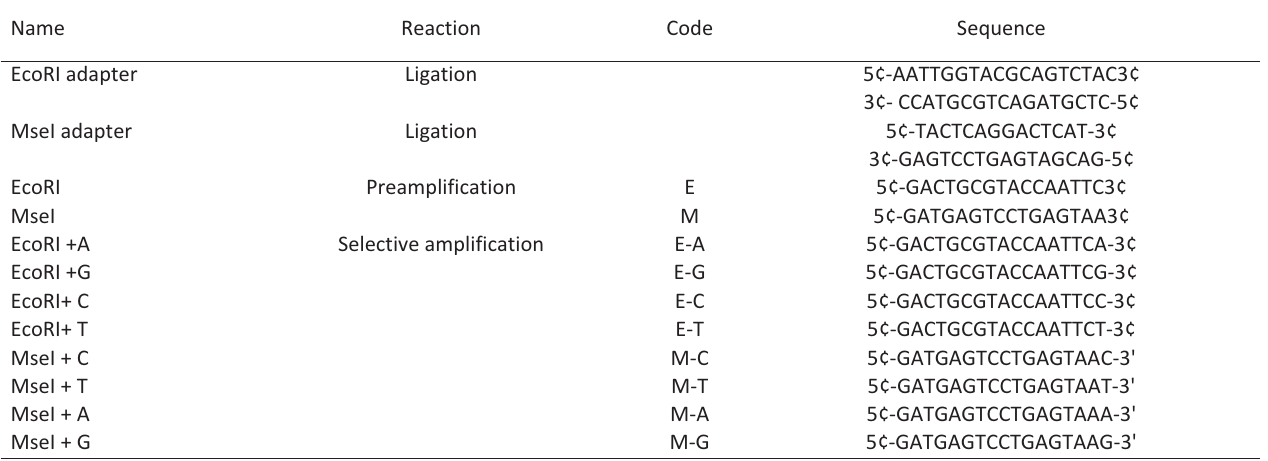
Table 1 - Sequences of oligonucleotide adapters and primers used in the pre amplification step and the selective AFLP primers combina- tions